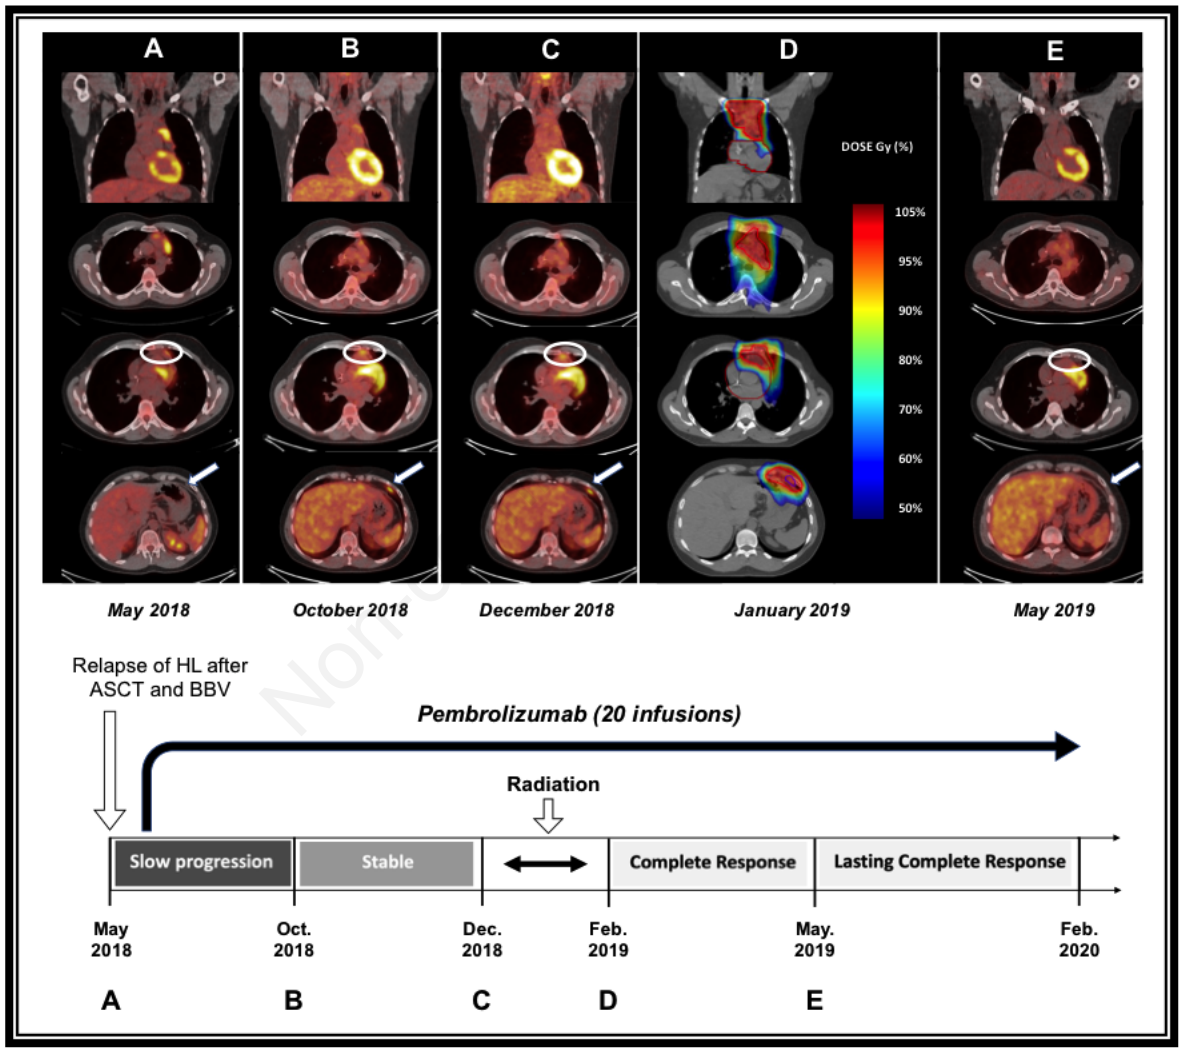
Figure 2. Timeline showing the disease status and therapy in patient 1 of our series. Panel (A) shows disease status before treatment with Pembrolizumab. Panel (B) shows partial response in the upper mediastinum, disease progression in a parasternal lymph node (inside the white circle) and appearance of a new cardiophrenic lymph node (shown by the white arrow) after 4 doses of Pembrolizumab. Panel (C) shows a stable disease after 4 additional doses of Pembrolizumab. Panel (D) shows the dose distribution of the RT treatment. The treatment was planned with an intensity modulated radiotherapy (IMRT) solution with multiple arcs. The pre- scribed dose was 36 Gy in 18 fractions. Panel (E) shows the complete metabolic response achieved 3 months after